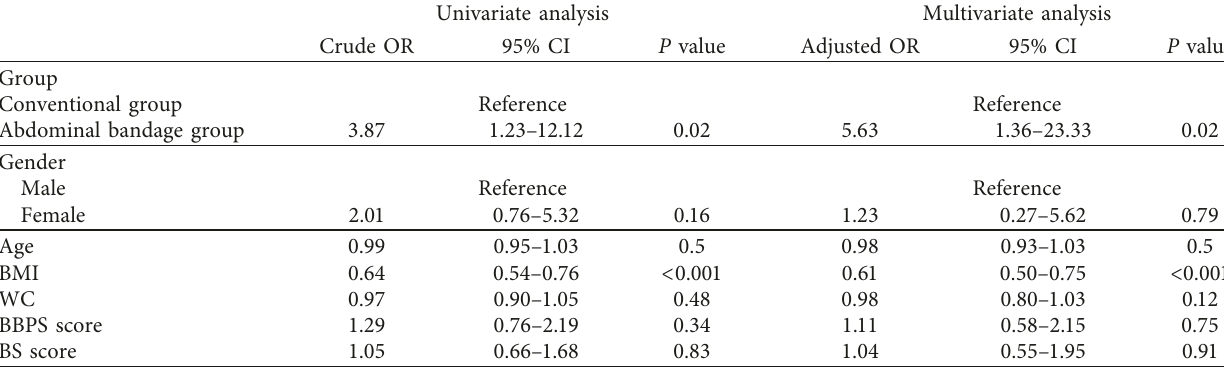
Table 3: Logistic regression analysis associated the factors with CCR.